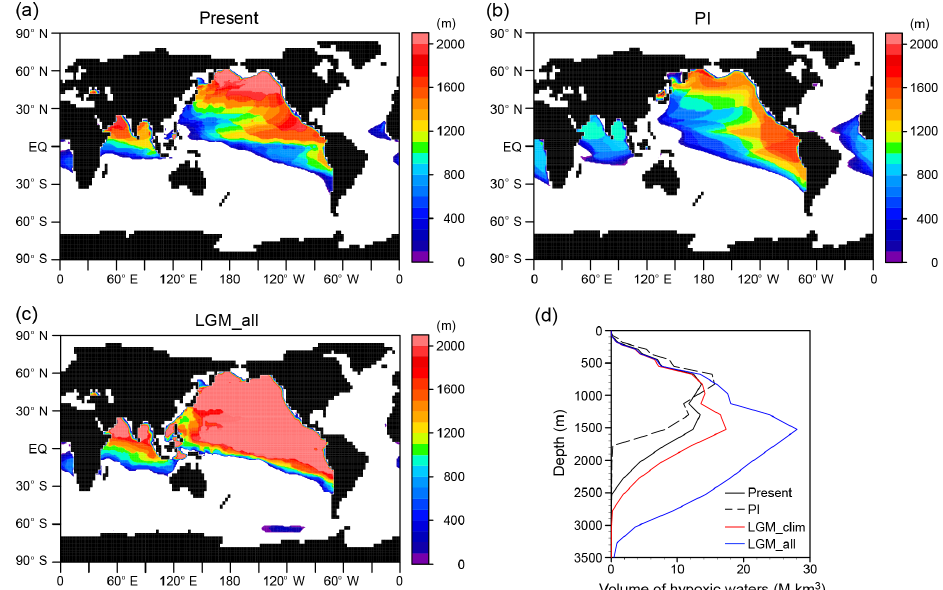
Figure 8. Hypoxic waters expansion. Horizontal distribution of thickness of the hypoxic waters ([O 2 ] < 80mmolm − 3 ) for the (a) present, (b) PI, and (c) LGM_all. (d) Vertical distribution of hypoxic waters for the present (black solid), PI (black dashed), LGM_clim (red), and LGM_all (blue). Because current coarse resolution models have difficulties reproducing low oxygen concentration for the present day (Bopp et al., 2013), observed values from WOA2009 (Garcia et al., 2010a) were used for the present. For the LGM simulations, we combined the observed values with the modeled